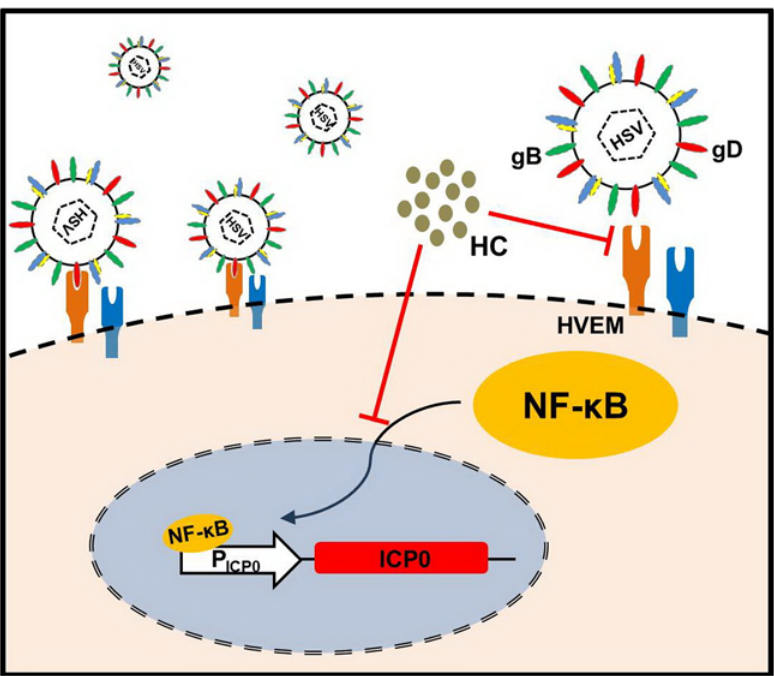
the transcriptional activity of ICP0 promoter through eliminating HSV-induced NF- κ B